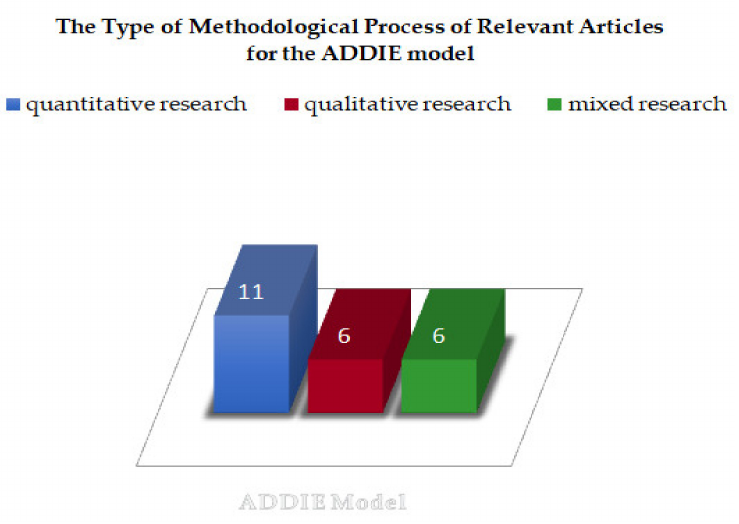
Figure 5. The type of methodological process of the relevant articles for the ADDIE model.